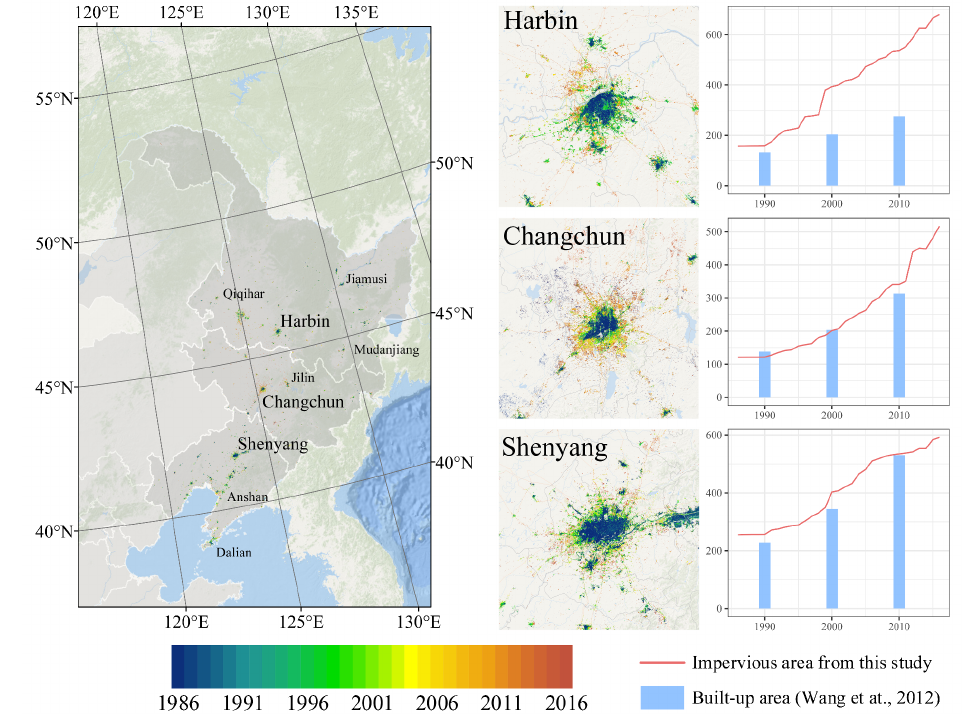
Figure 5. Urban extent extracted in the map series between 1986 and 2016.